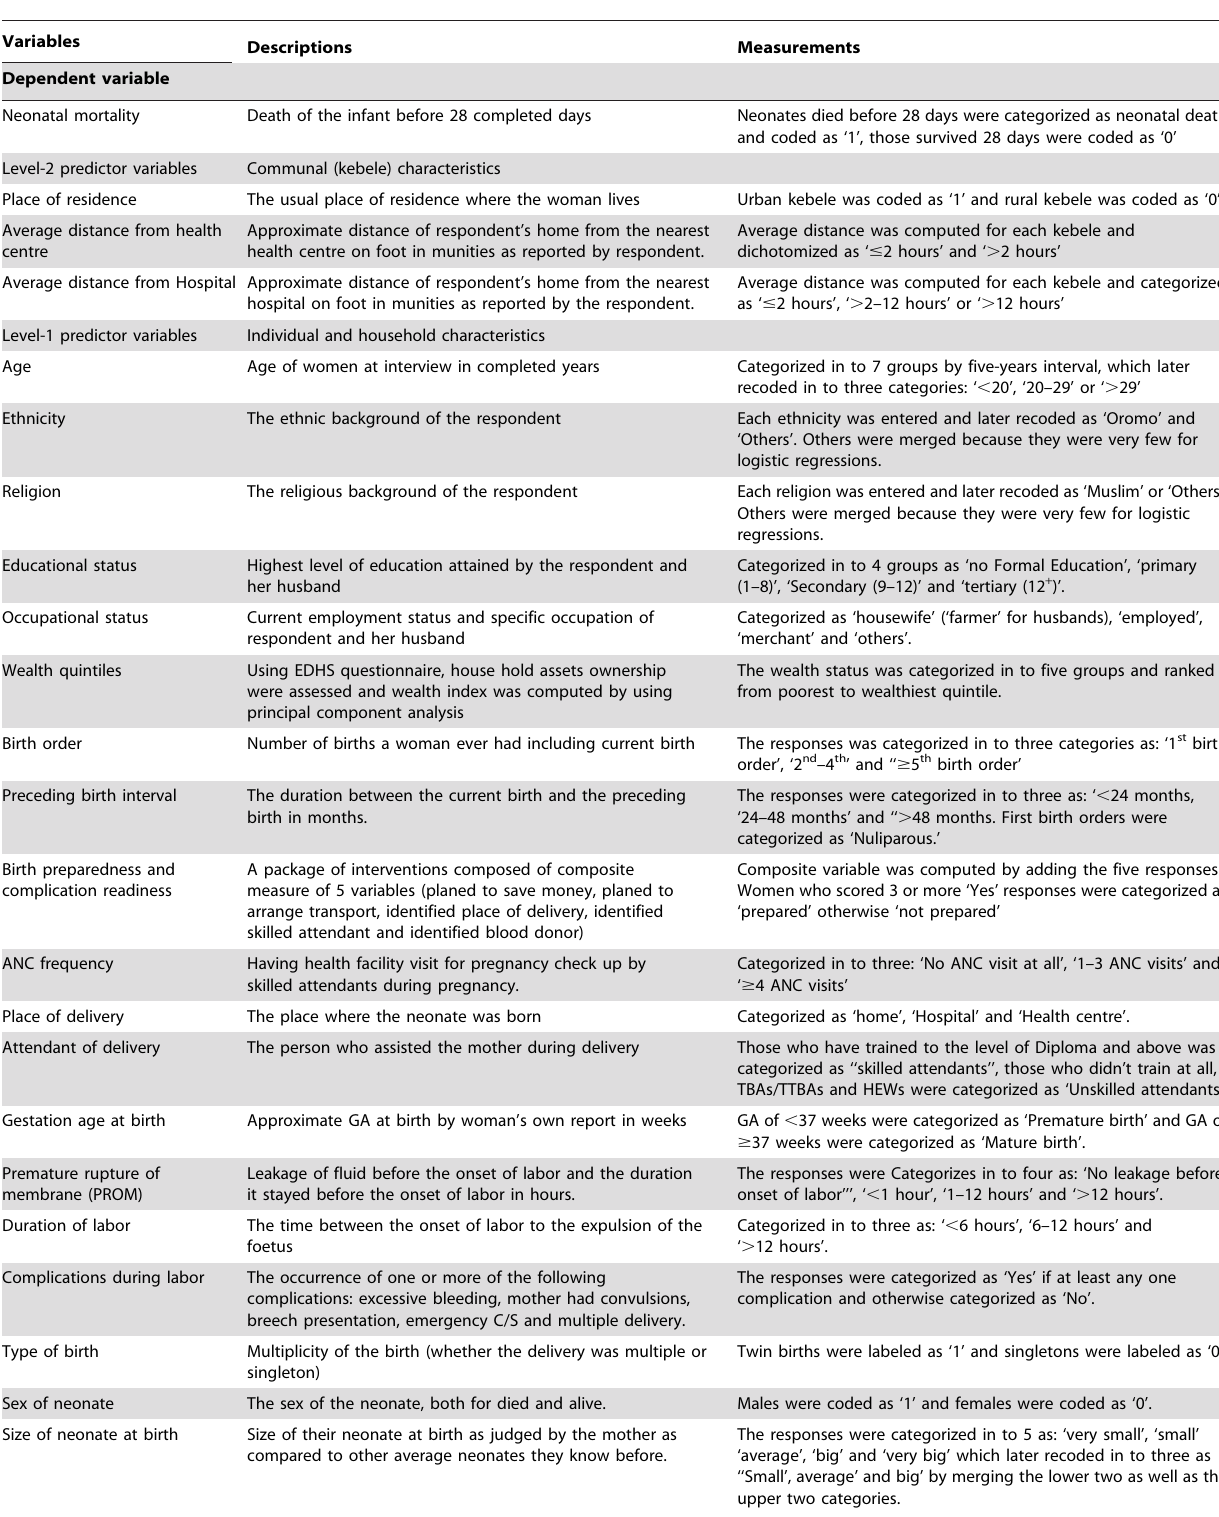
Table 1. Description of variables and measurement for the study, Jimma Zone, Southwest Ethiopia, September 2012-December